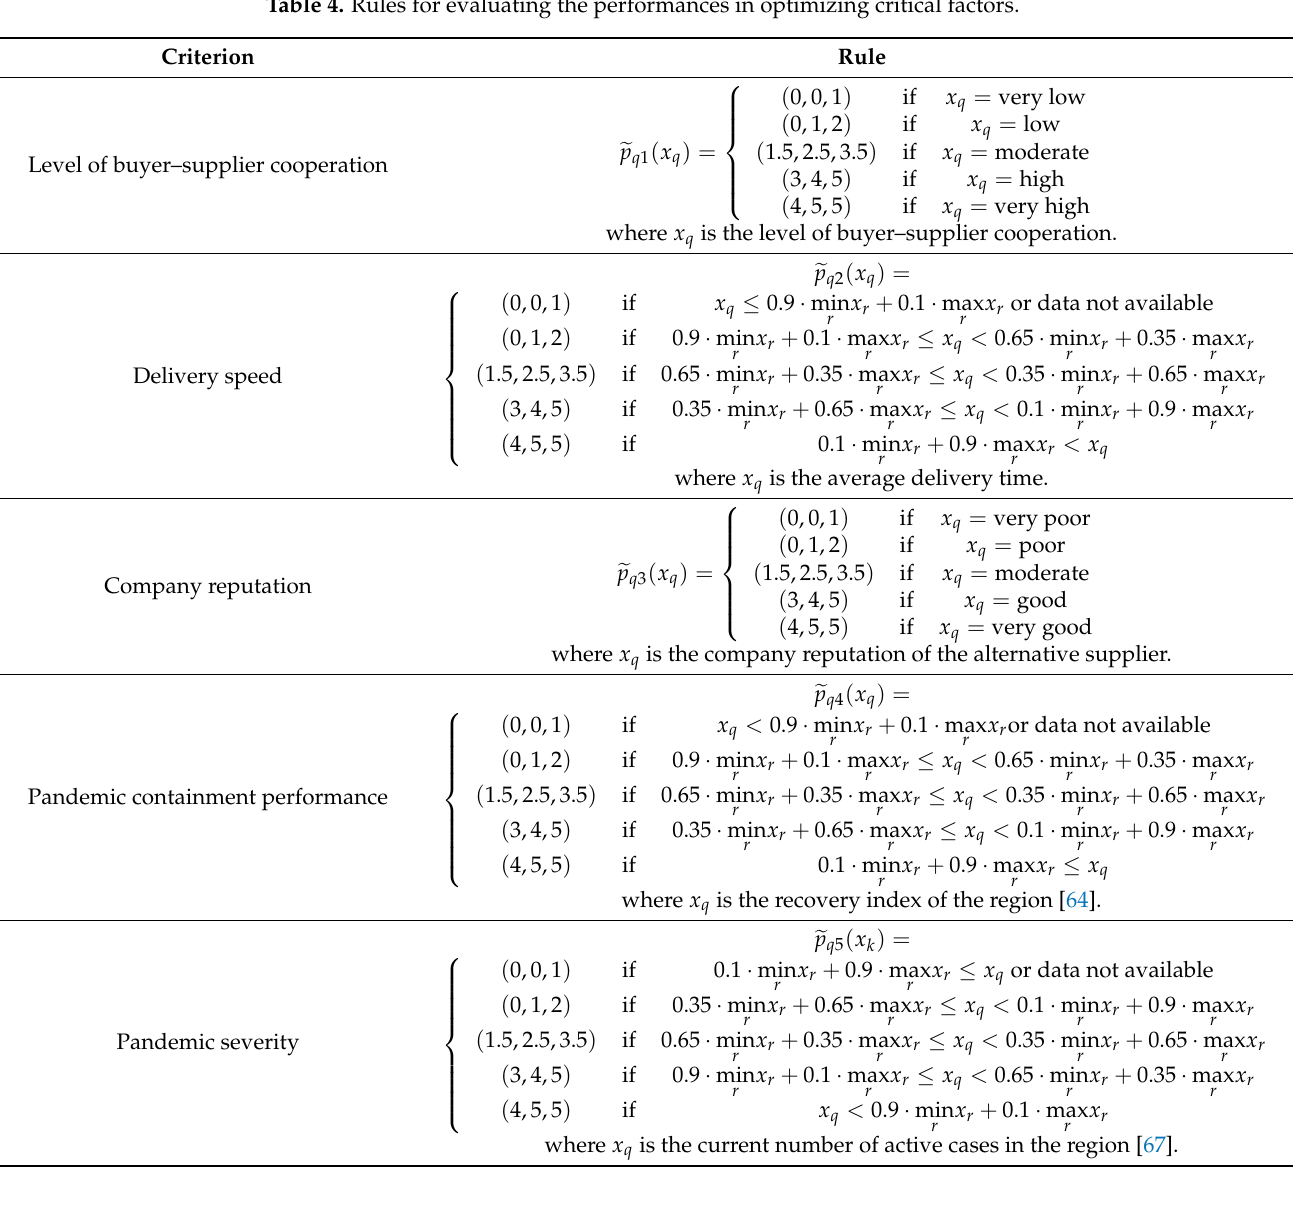
Table 4. Rules for evaluating the performances in optimizing critical factors.